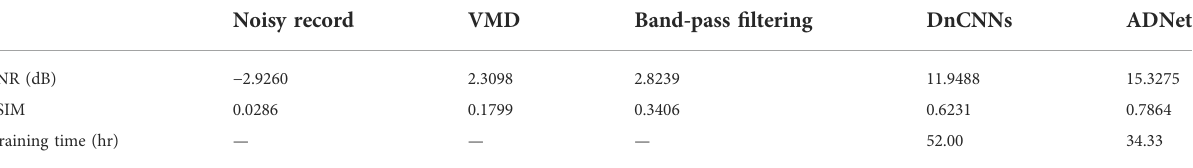
TABLE 2 Comparison of denoising performance of different